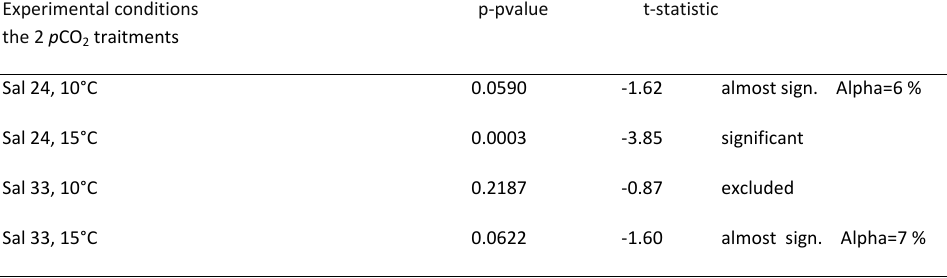
Legend fig 7, Ammonia tepida, Orbulina universa and Globigerinoides bulloides should be in